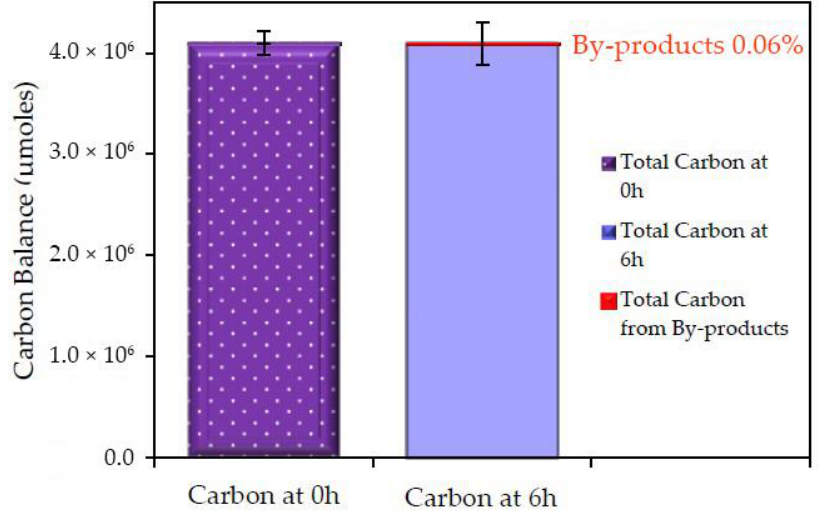
Figure 6. Total carbon from all carbon containing species, at the beginning of the reaction and after 6 h of near-UV irradiation. Conditions: argon atmosphere, 0.25 wt.% Pd-TiO 2 -nUV photocatalyst concentration.